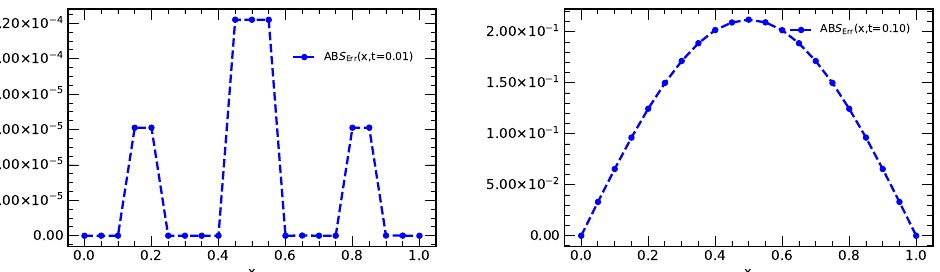
Figure 8. Plots of absolute errors vs. x at times 0.01, and 0.10 with ∆ x = 0.05 using n = 7 terms from